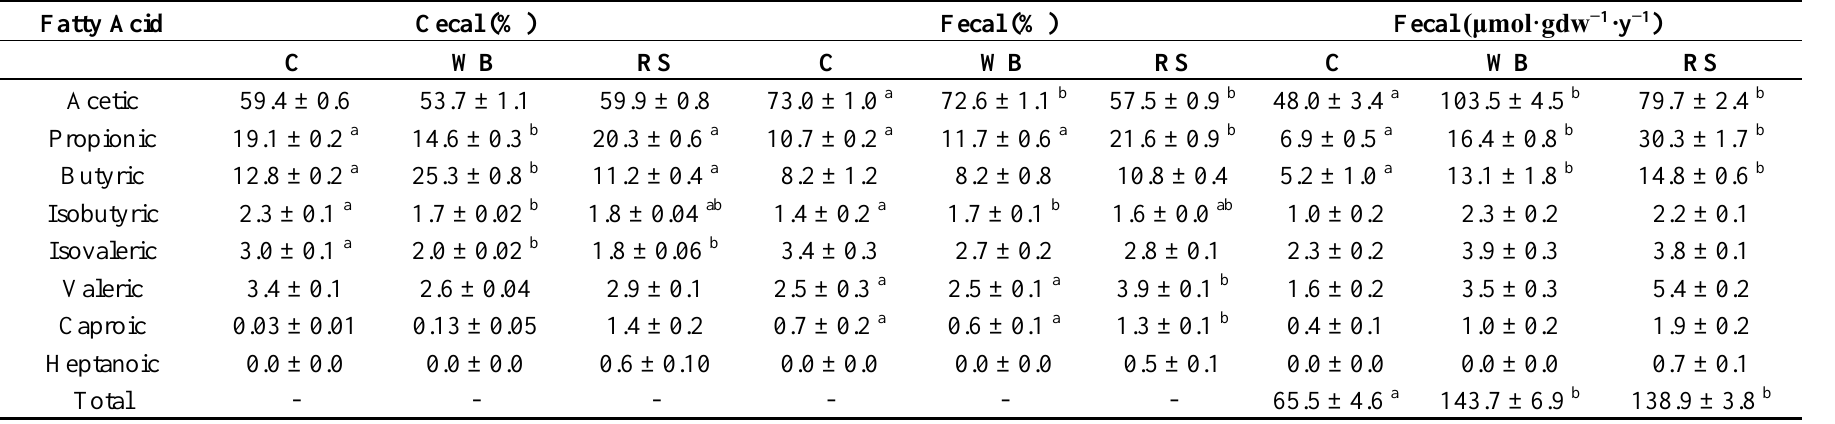
Table 1. Short chain fatty acid (SCFA) and branch chain fatty acid (BCFA) concentrations expressed as a percentage of the total in feces